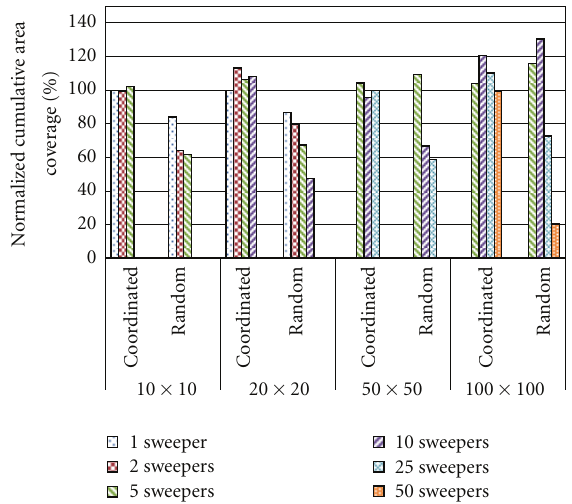
Figure 6: Area coverage in coordinated versus random motion